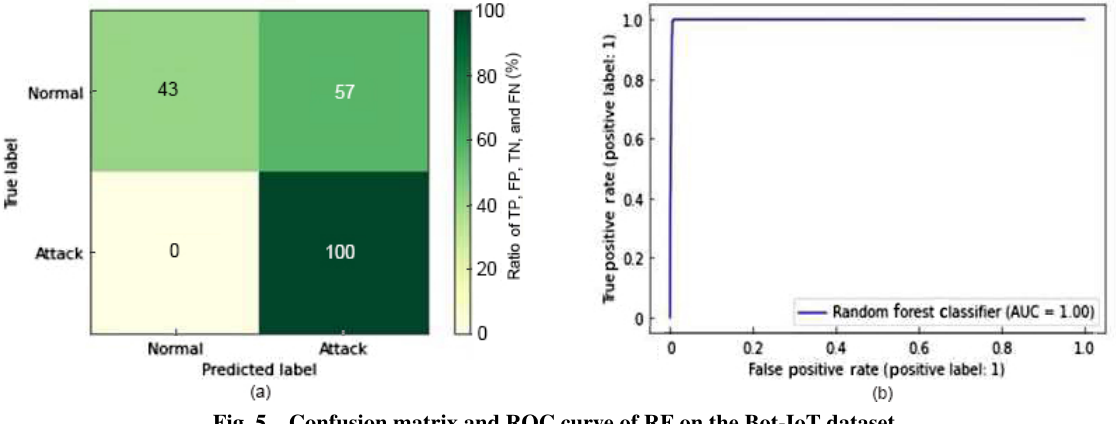
Fig. 5 Confusion matrix and ROC curve of RF on the Bot-IoT dataset.